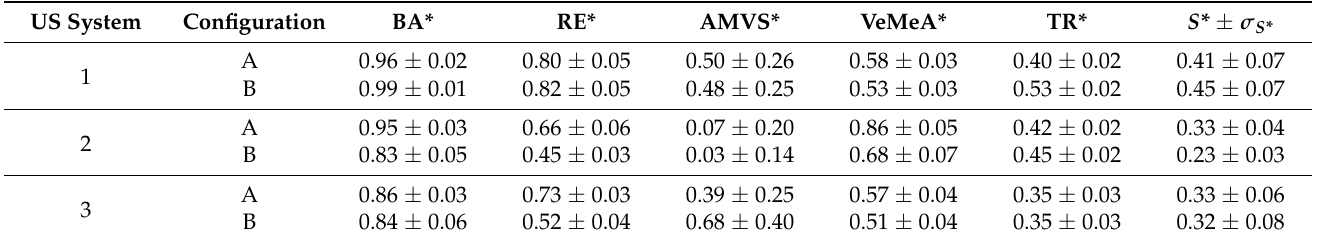
Table 14. Normalized QA test parameters and Kiviat diagram areas (mean ± SD) for systems 1, 2 and 3 equipped with phased array probes in configurations A and B at high flow regime.